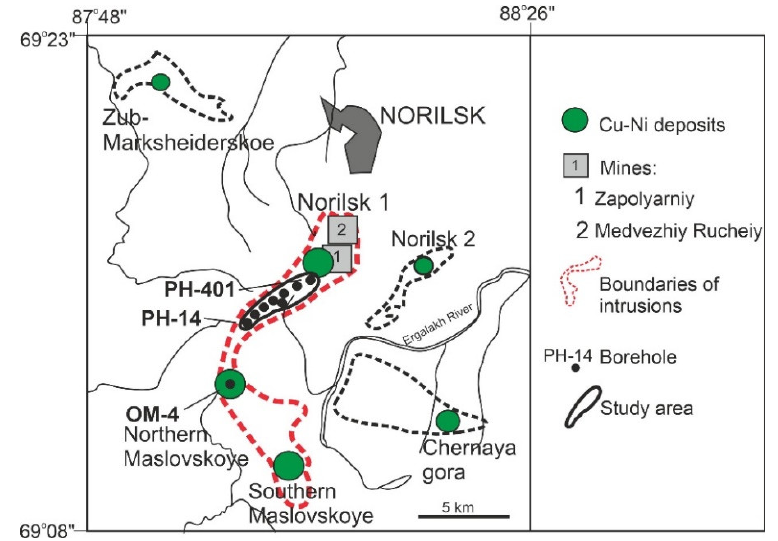
Figure 1. Map of location of ore-bearing intrusions and deposits of the Norilsk District, modified from Figure1. [3,28].